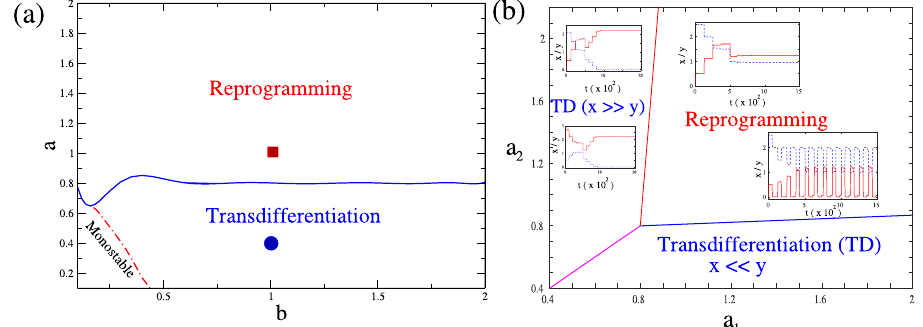
Figure 5. ( a ) Parameter phase plane in the positive feedback ( a ) vs negative feedback ( b ) plane for the case of symmetric parameters, a = a 1 = a 2 and b = b 1 = b 2 . The parameter point shown as a red square corresponds to the parameter set for the trajectories shown in Fig. 2, while the point shown as a blue circle corresponds to the parameter set for the trajectories shown in Fig. 3. ( b ) Parameter phase plane in the a 1 vs. a 2 plane for the case of asymmetric parameters for b = 1. The insets in the reprogramming region of the phase plane show the time trajectories of the transcription factors for a 1 = 1.0, a 2 = 1.2, d = 150 for the reprogramming to the central attractor and a 1 = 1.0, a 2 = 1.2, d = 50 for the long-lived oscillatory state. The insets in the transdifferentiation region of the phase plane show the time trajectories for a 1 = 0.6, a 2 = 1.2, d = 500 starting from two different initial states, one with  x y , which shows transdifferentiation, and the other with  x y , which does not. All other parameters for both panels are the same as those in Fig. 1. All results are shown for Δ τ =